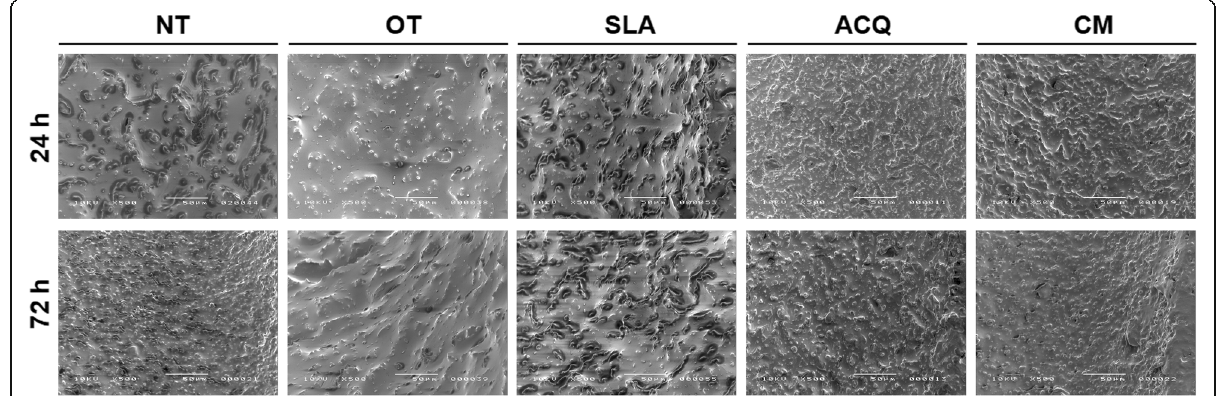
Fig. 5 SEM photomicrographs of Saos-2 cell adhesion and proliferation. SEM images of Saos-2 cells on NT, OT, SLA, ACQ, and CM dental implant surfaces after 24 and 72 h, adhesion and proliferation respectively (× 500